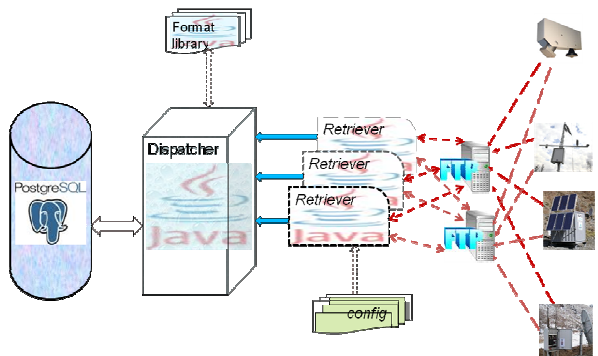
Fig. 7: SOPAF – collection and processing of information. The retrievers are forwarding the 3 Fig. 7. SOPAF – collection and processing of information. The re- newly arrived data. The dispatcher converts the information into the SOS data model using 4 trievers are forwarding the newly arrived data. The dispatcher con- the translation information of the format-library. 5 verts the information into the SOS data model using the translation As hardware infrastructure, SOPAF uses two independent but identical Sun Fire X4600 6 information of the servers to increase the access availability and to allow a faster data access in both from 7 Central Asia and the world. The base operating system of the computers is NOVELL SUSE 8 Linux Enterprise 11, which controls Ubuntu 10.04 in virtual machines. For the realization of 9 the SOPAF system, the JAVA EE technology 1 , Enterprise JavaBeans 2 , JavaServer Faces 10 Technology (JSF) 3 , Java Message Service (JMS) 4 and the Extensible Markup Language 11 (XML) were chosen as developing tools. The data model is implemented in the object-12 relational database management system PostgreSQL (www.postgresql.org) Version 8.4. The 13